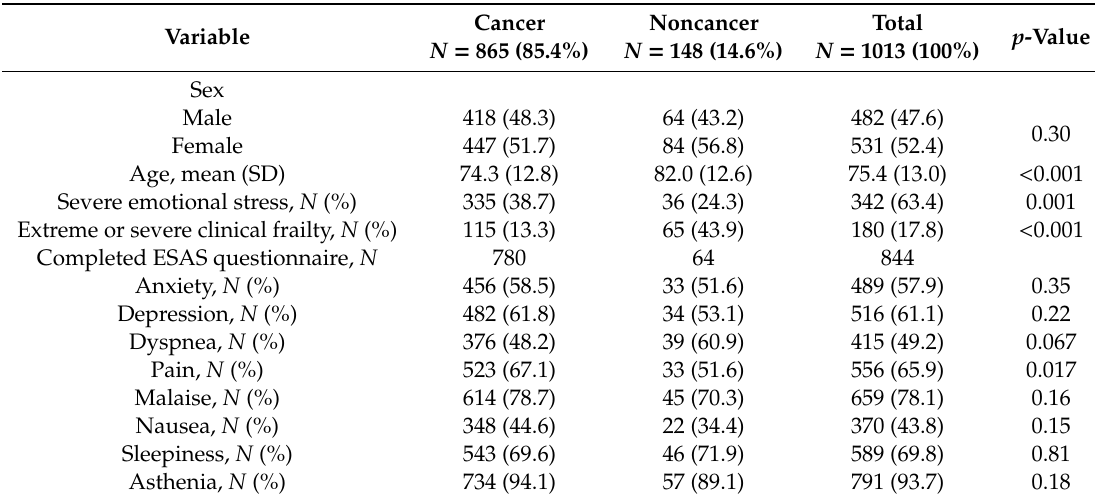
Table 3. Main demanding problems observed in patients who accessed the local palliative care networks, stratified by